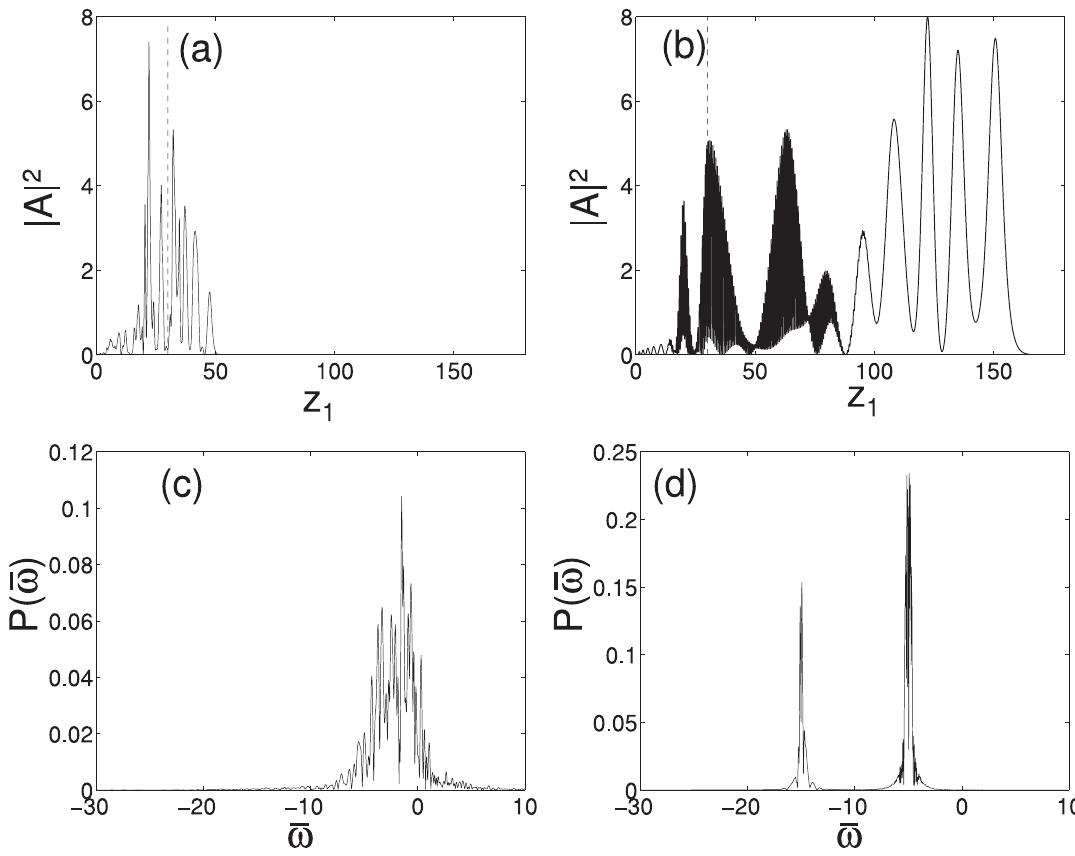
(cid:1) 30 L and (cid:5) (cid:1) 0 , in the classical regime ( (cid:1) (cid:1) (cid:1) 5 and (cid:1) z (cid:1) 30 ) (a), (c) and b c , where ! is the resonance frequency. The dotted line 2 (cid:1)!